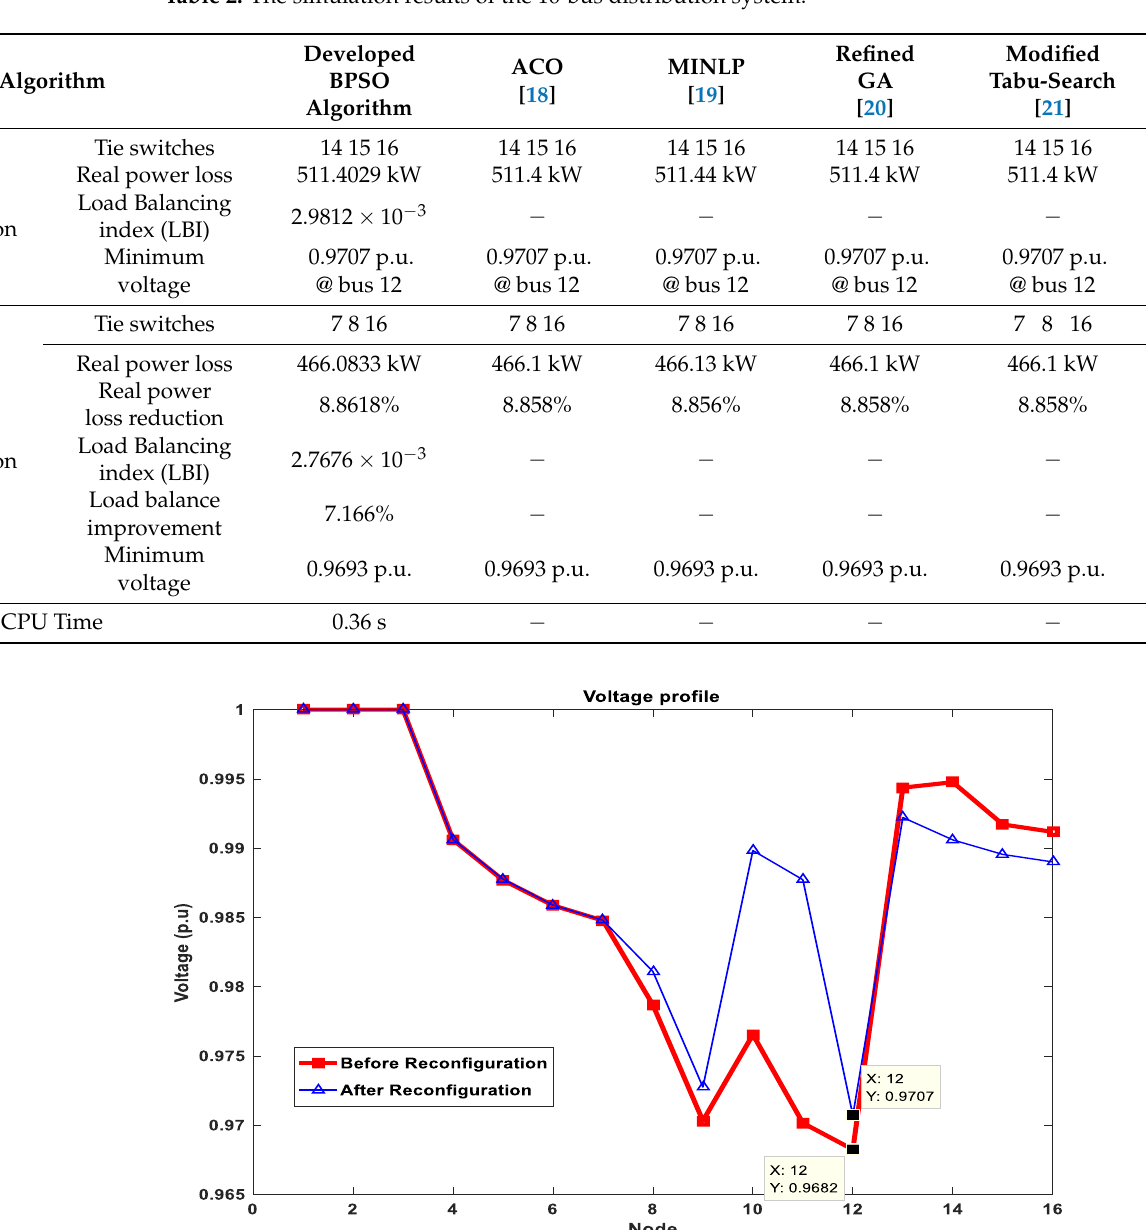
Table 2. The simulation results of the 16-bus distribution system.